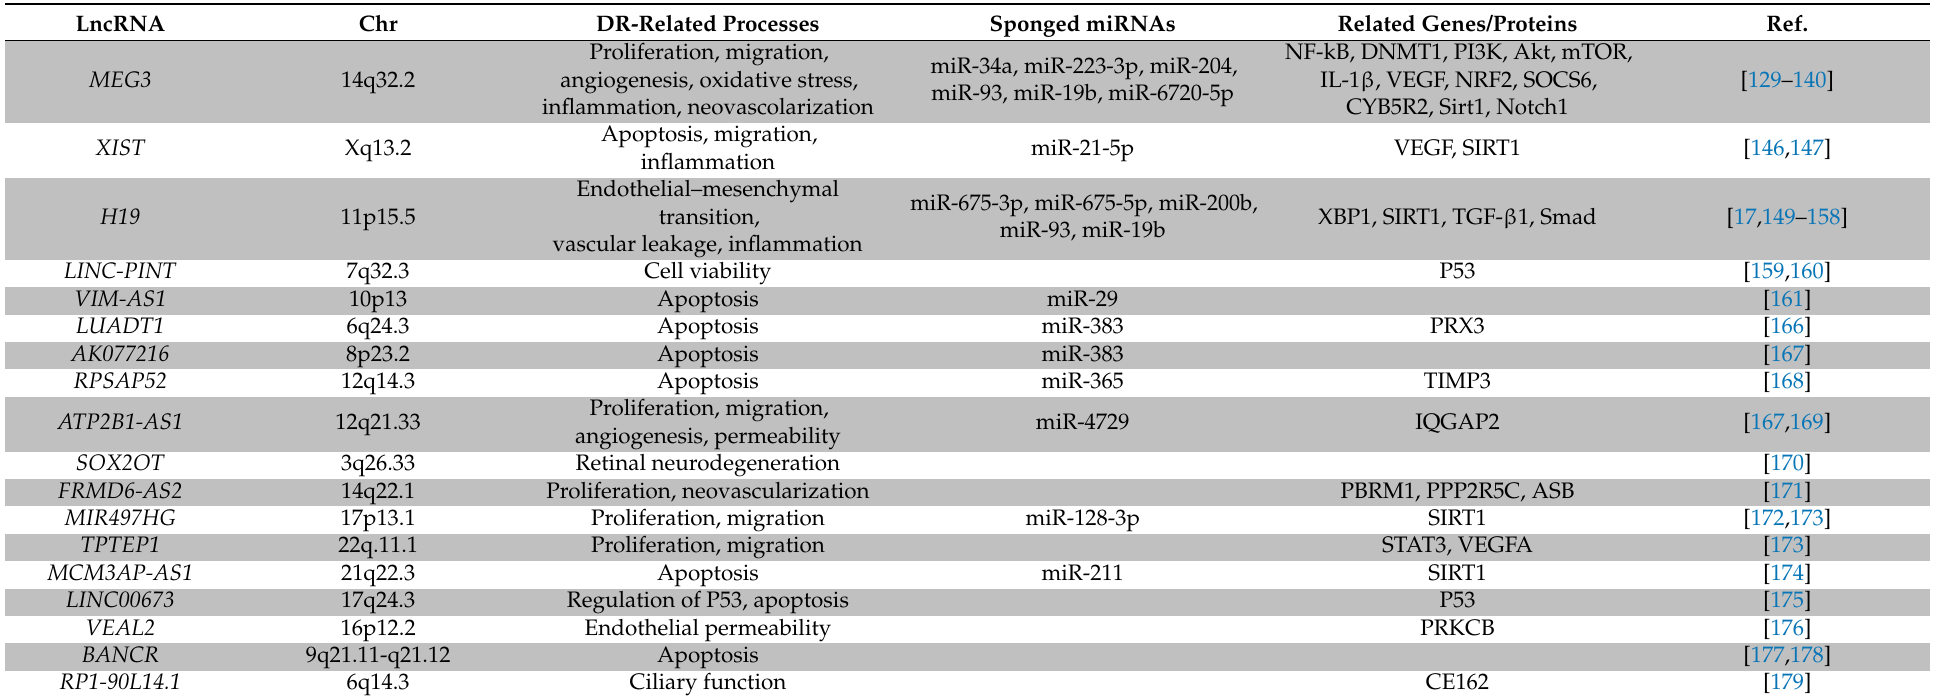
Table 2. Long non-coding RNAs reported as s downregulated in diabetic